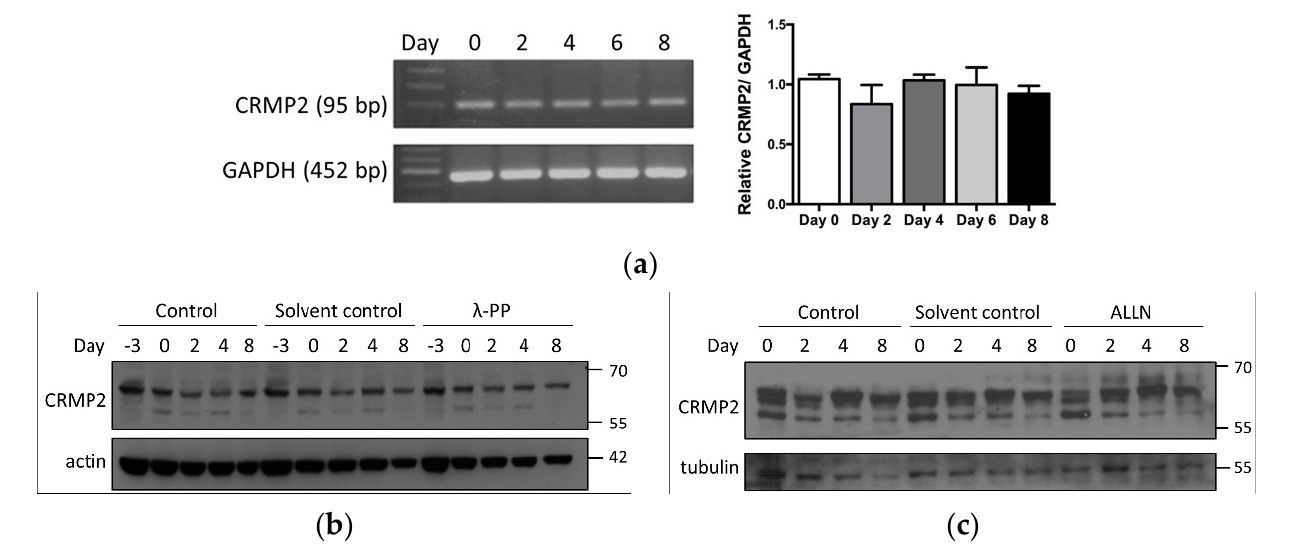
Figure 2. Transcriptional control and post − transcriptional modification of CRMP2 during adipogenesis. ( a ) CRMP2 mRNA levels were examined by RT-PCR ( n = 3). ( b , c ) 3T3-L1 pre-adipocytes were subjected to differentiation in the presence of ( b ) λ -PP phosphatase or ( c ) calpain inhibitor ALLN treatment. Cell lysates were collected at the indicated time and subjected to protein analysis by Western blotting ( n = 4).